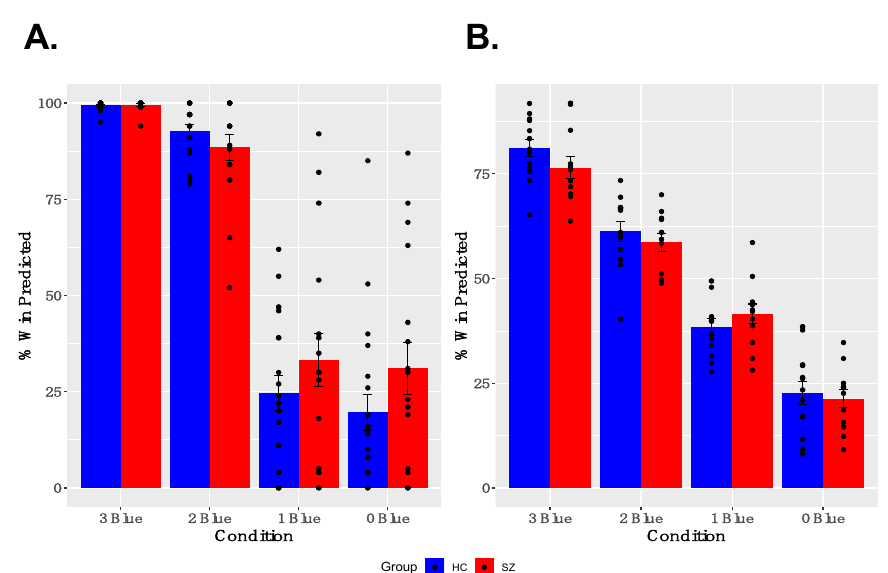
Figure 2. Behavior Results: ( A ) Participants modulated their trial-by-trial predictions of winning, based on the reward probabilities associated with each cue. ( B ) Participants successfully estimated reward probabilities associated with each cue at the between neuroimaging task runs.